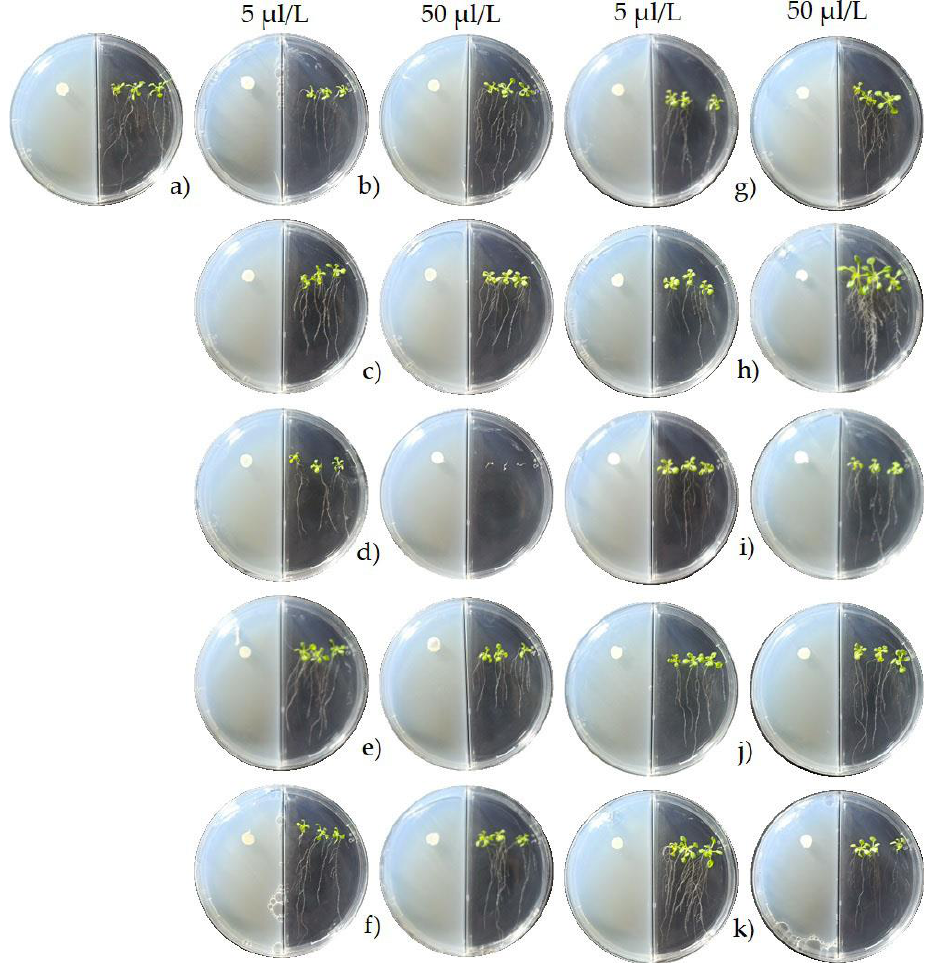
Figure 6. Appearance of A . thaliana seedlings after exposure for 10 days to pure VOCs (5 and 50 µ L/L). The assay was performed using divided Petri dishes; A . thaliana seeds were sown on the right, and pure VOCs were sown on the left of the dishes: ( a ) control; ( b ) 2-pentanone; ( c ) 2-(methylthio) ethanol; ( d ) trans -2-hexenal; ( e ) 2,5- dimethylfuran; ( f ) α -pinene; ( g ) 2-methyl-3-pentanone; ( h ) 3-methyl-2-butanol; ( i ) geosmin + 2-methylisoborneol; ( j ) valencene; and ( k ) dimethyl disulfide.